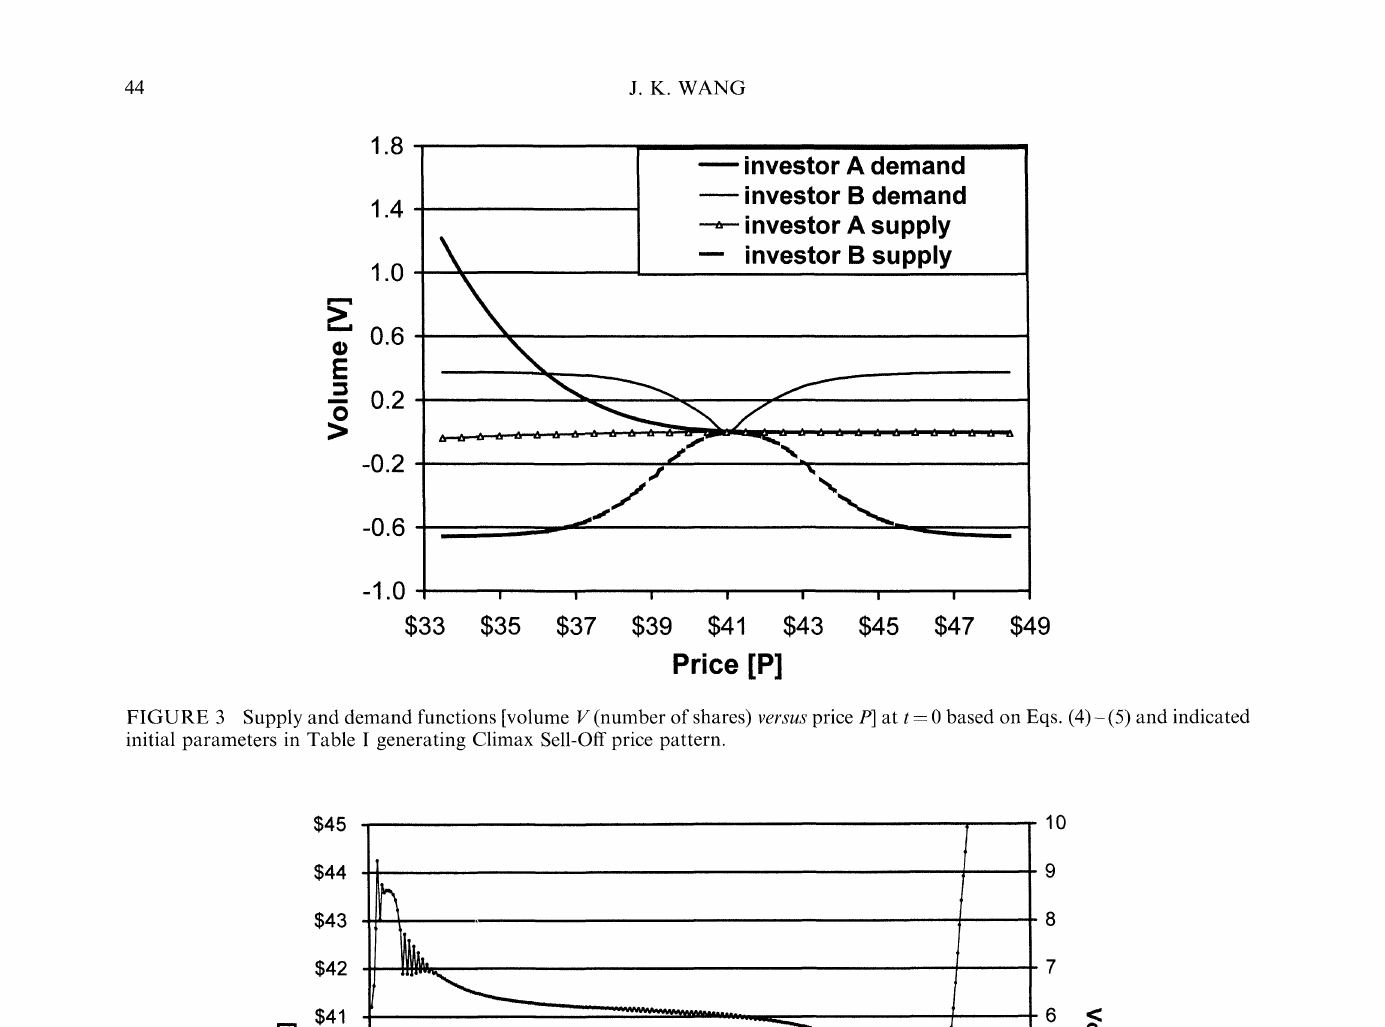
FIGURE 4 Sell-Off price pattern [price P and volume V versus time t] generated from Eqs. (1)-(5) and indicated initial parameters in Table I. rise in near-future time periods. In comparison